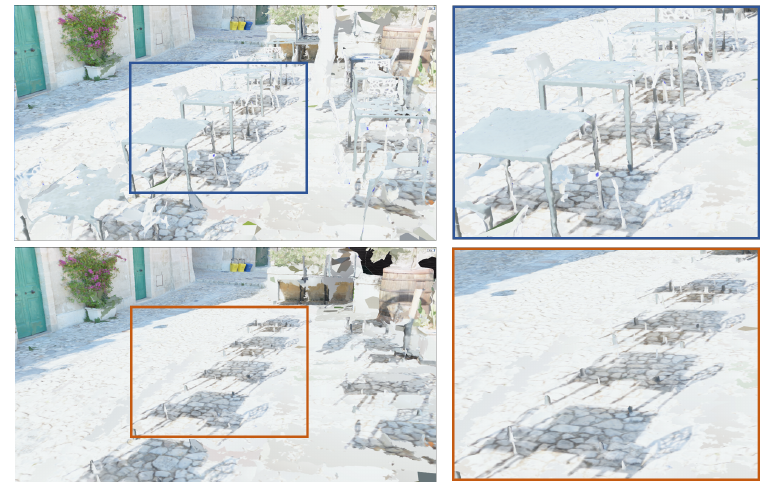
Figure 5. Before and after the removing of the deformed objects, with a zoomed-in view where their shadows are still observable.